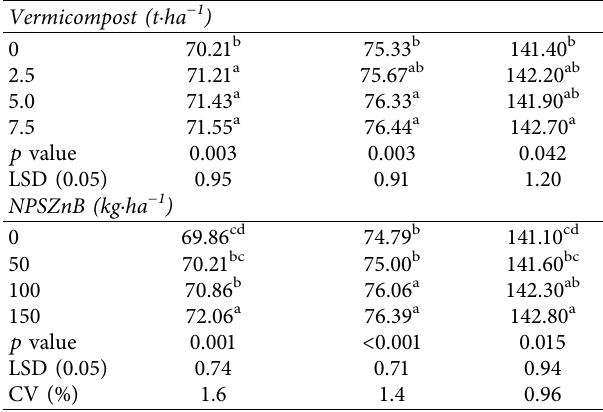
Table 3: Main efect of vermicompost levels and inorganic NPSZnB fertilizer rates on the number of days to 50% of the days to tassel, number of days to 50% silking, and the number of days to 90% physiological maturity of maize in Guto Gida, Western